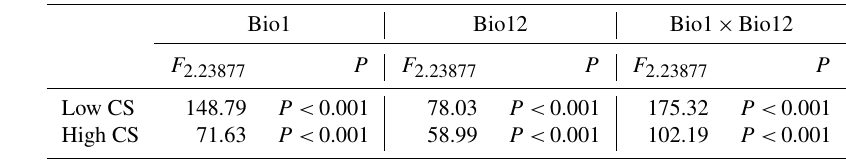
Table 2. Effects of annual mean temperature and annual precipitation on potential invasion pathways in protected areas (PAs) in both low- and high-gas-concentration scenarios based on two-way ANOVA.